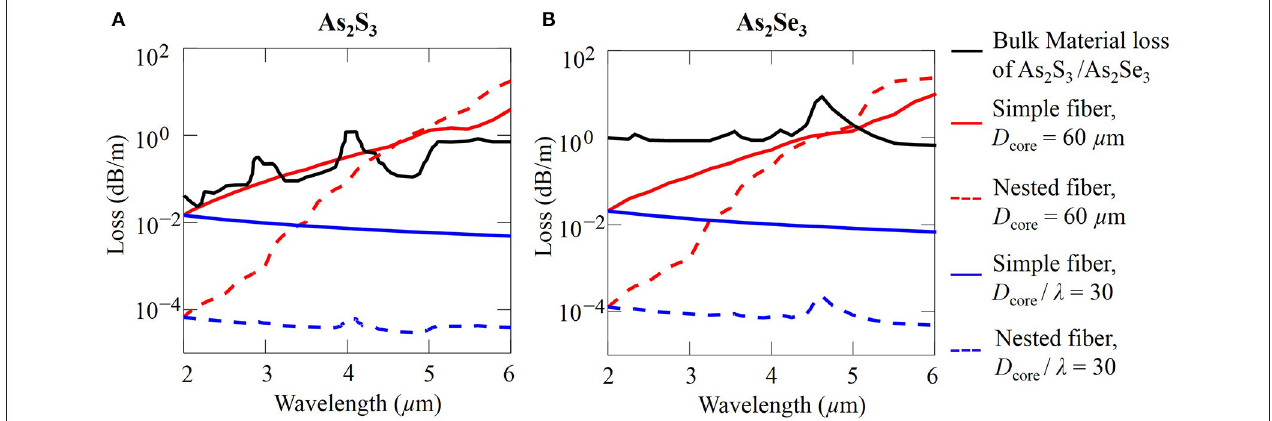
FIGURE 10 | Fiber loss of simple and nested negative curvature fibers made with (A) As 2 S 3 chalcogenide, and (B) As 2 Se 3 chalcogenide glasses.